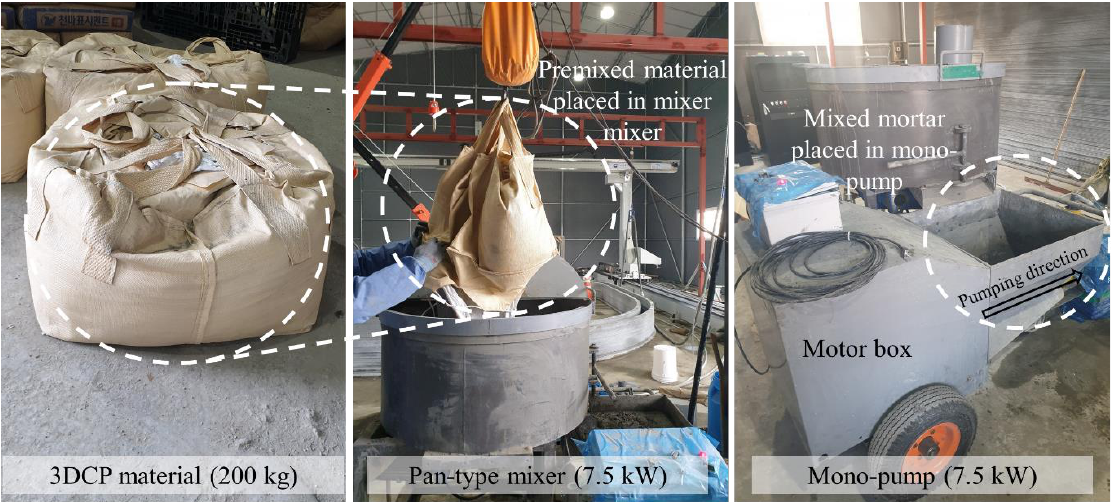
Figure 4. Premixed material, pan-type mixer, and mono-pump.